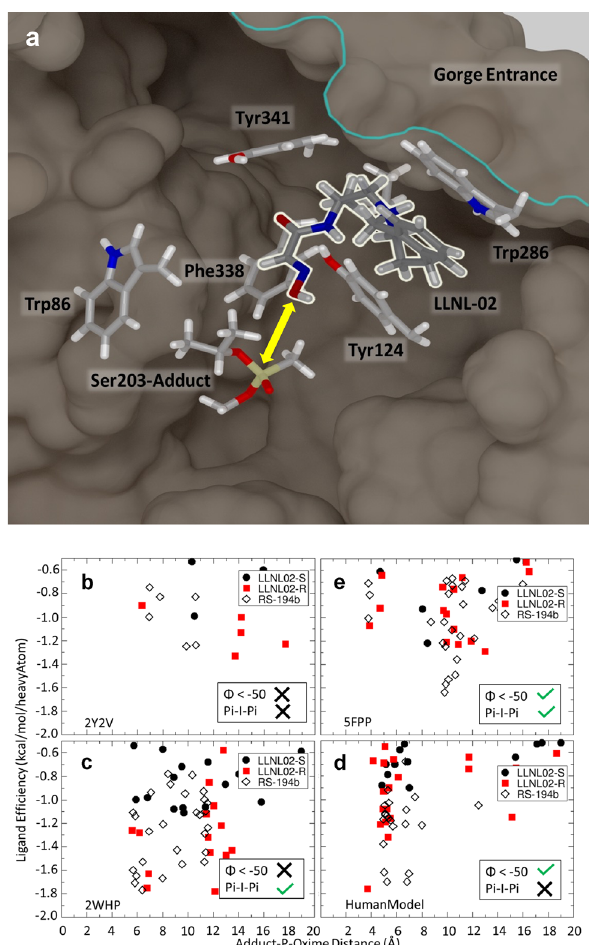
Figure 3. Example LLNL-02 ( 1 ) pose from the docking calculations. ( a ) AChE active site residues with LLNL- 02 docked in an in-line orientation. The addition of the aromatic moiety creates a π–π stacking interaction with Tyr124 and Trp286. A hydrophobic pocket is filled by the LLNL-02 methyl group which interacts with Ile293, Tyr341, and Phe338 in the rat AChE crystal structure (5FPP). The phosphorus-oxime distance is ~ 4.7 Å which approximates an enzymatic encounter complex (yellow arrow). Figure was created with VMD 60 . ( b ) Docking results for the ( c ) 2Y2V, ( d ) 2WHP, ( e ) HumanModel, and ( e ) 5FPP protein targets. LLNL-02 enantiomers and RS-194B ligand efficiencies versus the distance between the oxime oxygen and phosphorous atoms (P–O distance) are shown. The selection of R over S enantiomers in 5FPP and 2WHP is a result of the π–π sandwich interaction. In addition, the shortened P–O distances in the 5FPP and HumanModel targets are a result of the ~ 50° rotation in the torsion angle between the methyl and isopropyl groups of the adduct. This large rotation also shortens the distance between the isopropyl tail and Trp86 sidechain by 1 Å, effectively blocking adjacent binding. The removal of the π–π sandwich interaction in the Human Model allows both LLNL-02 enantiomers to interact with Trp286 with either face of the benzoazepine ring. Together, these results show that the addition of the methyl group and benzo moiety slightly altered ligand efficiencies and P–O distances compared to RS-194B while significantly increasing